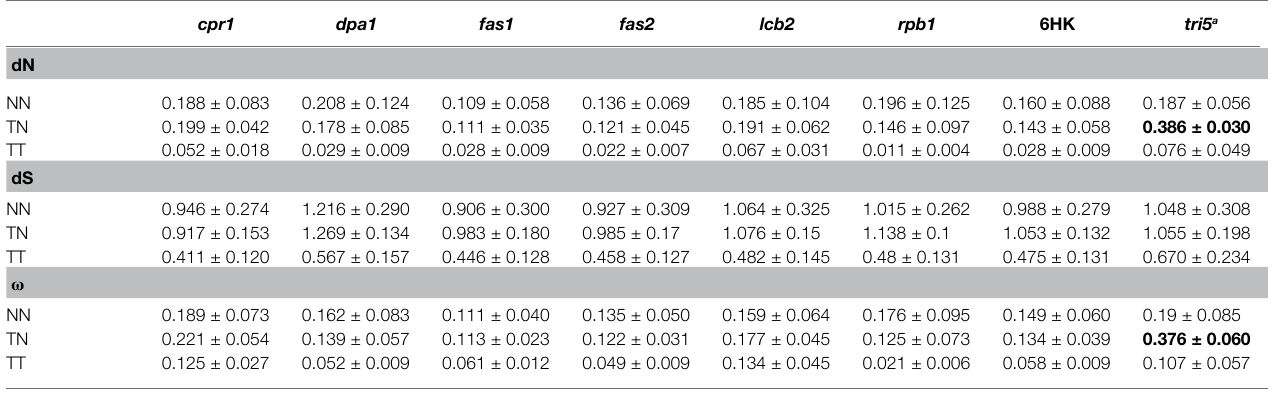
TABLE 3 | Divergence values (mean ± sd) for pairwise combinations of sequences. cpr1